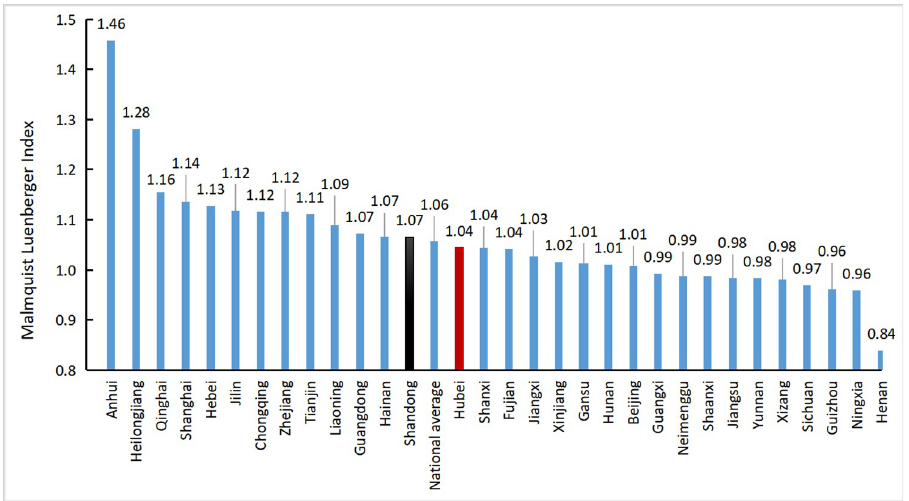
Fig 4. Histogram of ML index for 31